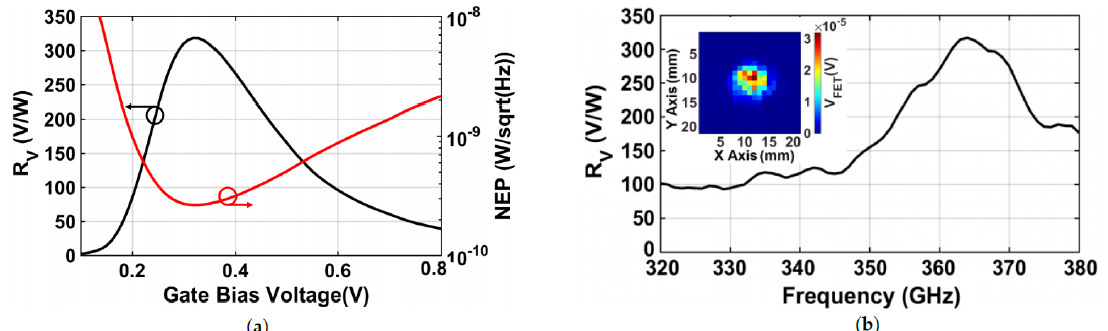
Figure 16. Measured FET voltage responsivity and Noise Equivalent Power (NEP) versus gate bias